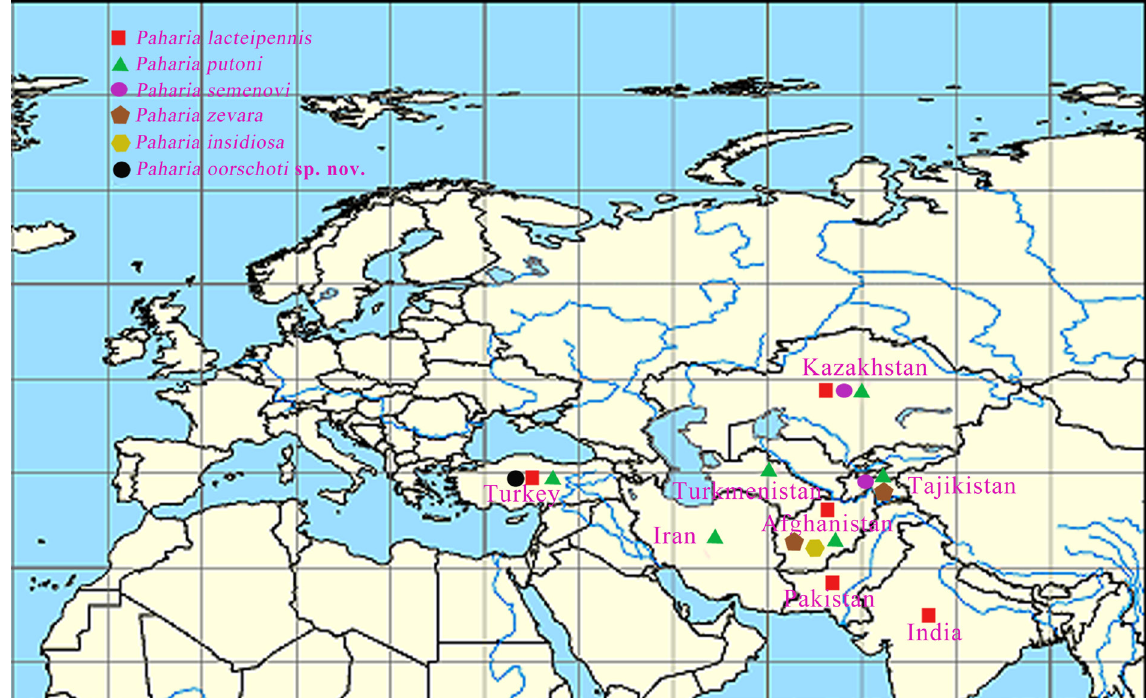
Fig. 5. Distribution of the species of Paharia . Red square = Pa. lacteipennis (Walker, 1850); green triangle = Pa. putoni (Distant, 1892); purple circle = Pa. semenovi (Oshanin, 1906); brown pentagon = Pa. zevara (Kusnezov, 1931); yellow hexagon = Pa. insidiosa (Boulard, 1977) comb. nov.; black circle = Pa. oorschoti sp.